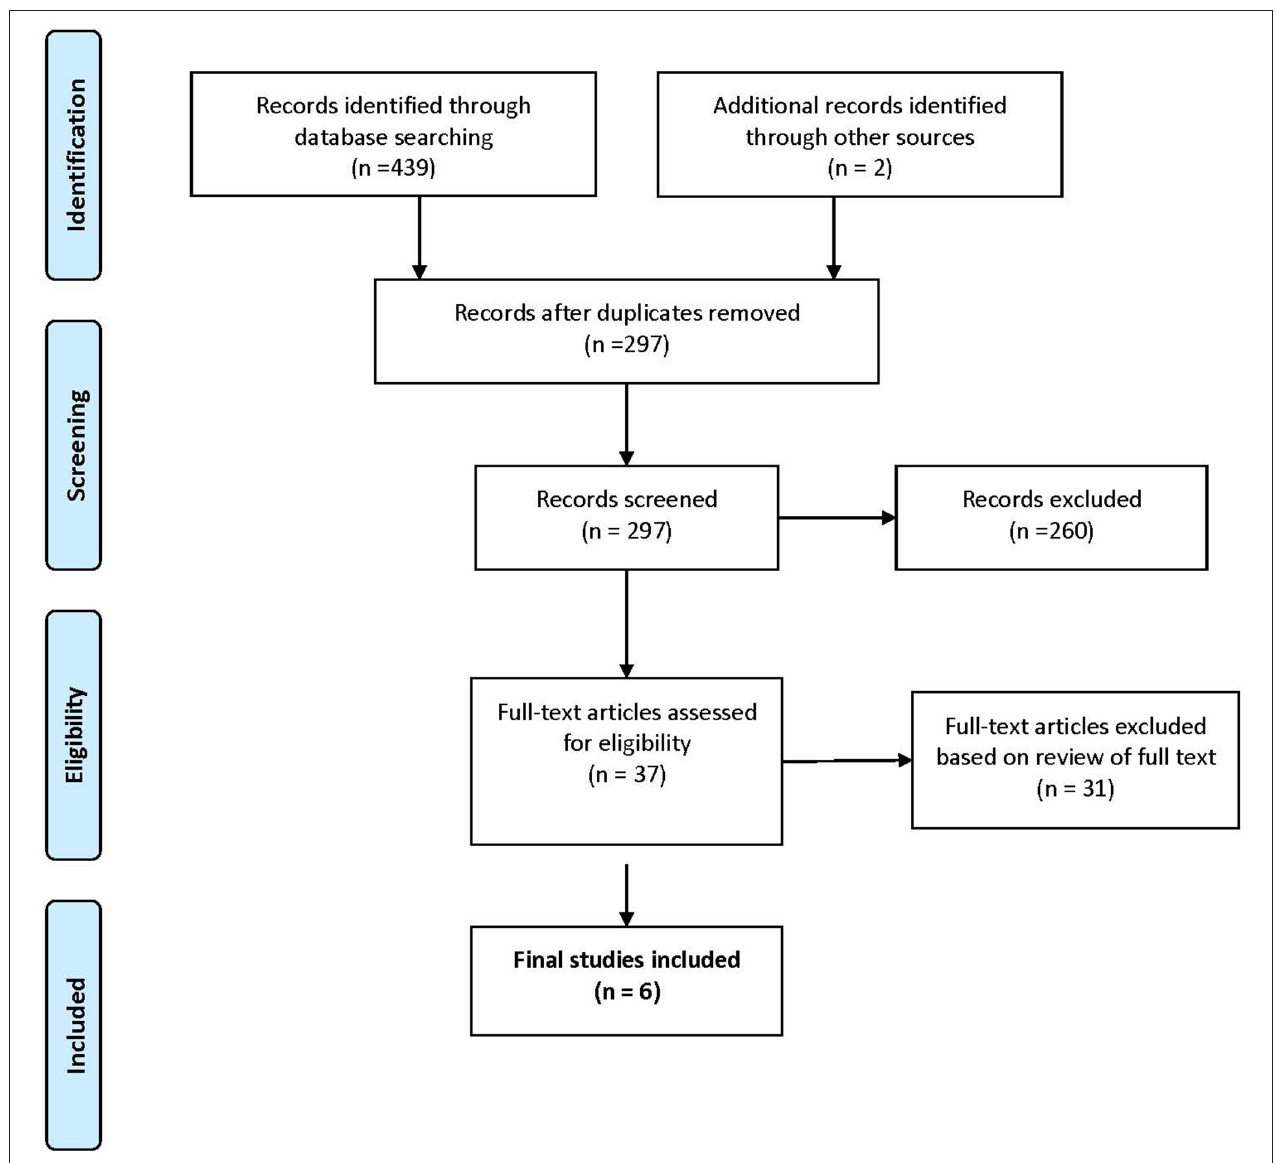
FIGURE 1 | (PRISMA) diagram of results of search and selection of